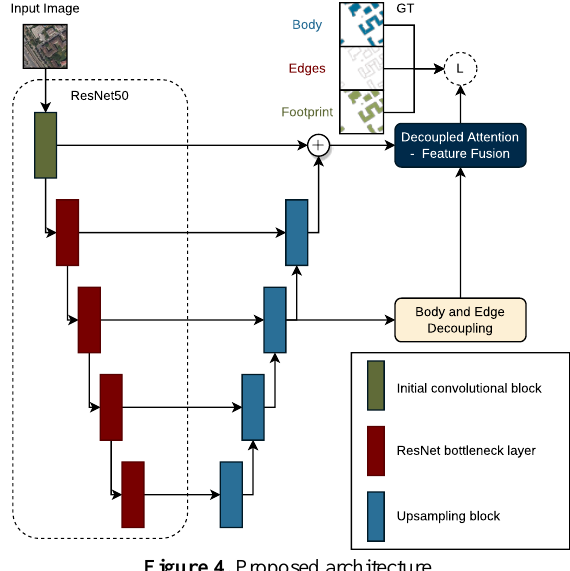
Figure 4. Proposed